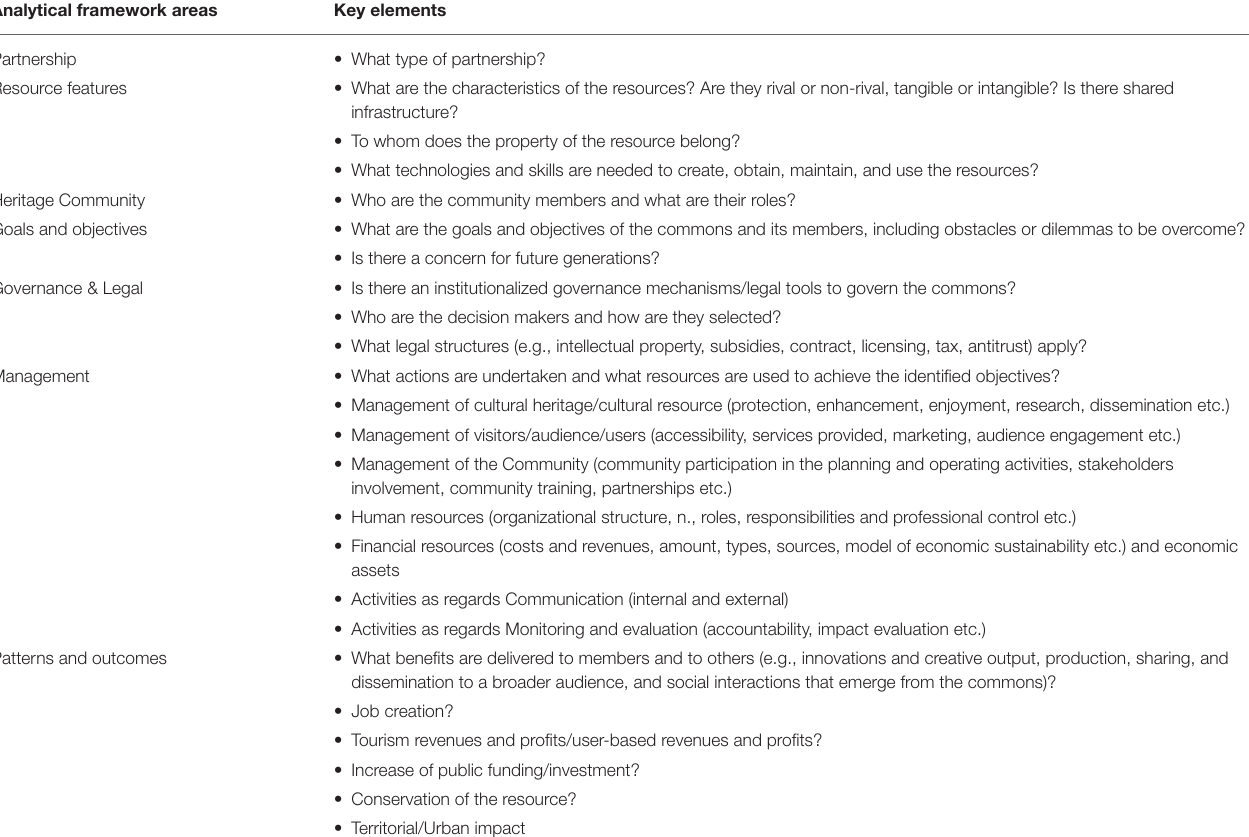
TABLE 1 | Analytical grid for cultural heritage commons in urban and peri-urban areas a . Analytical framework areas Key